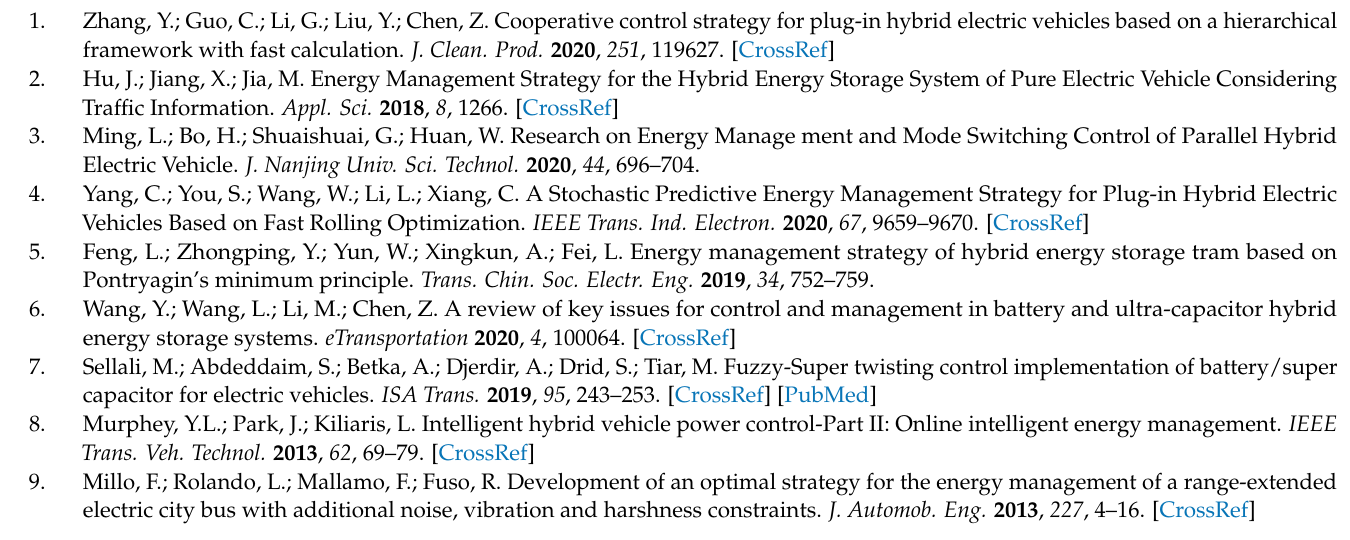
Figure 28. The battery and super-capacitor current response during the whole road cycle.